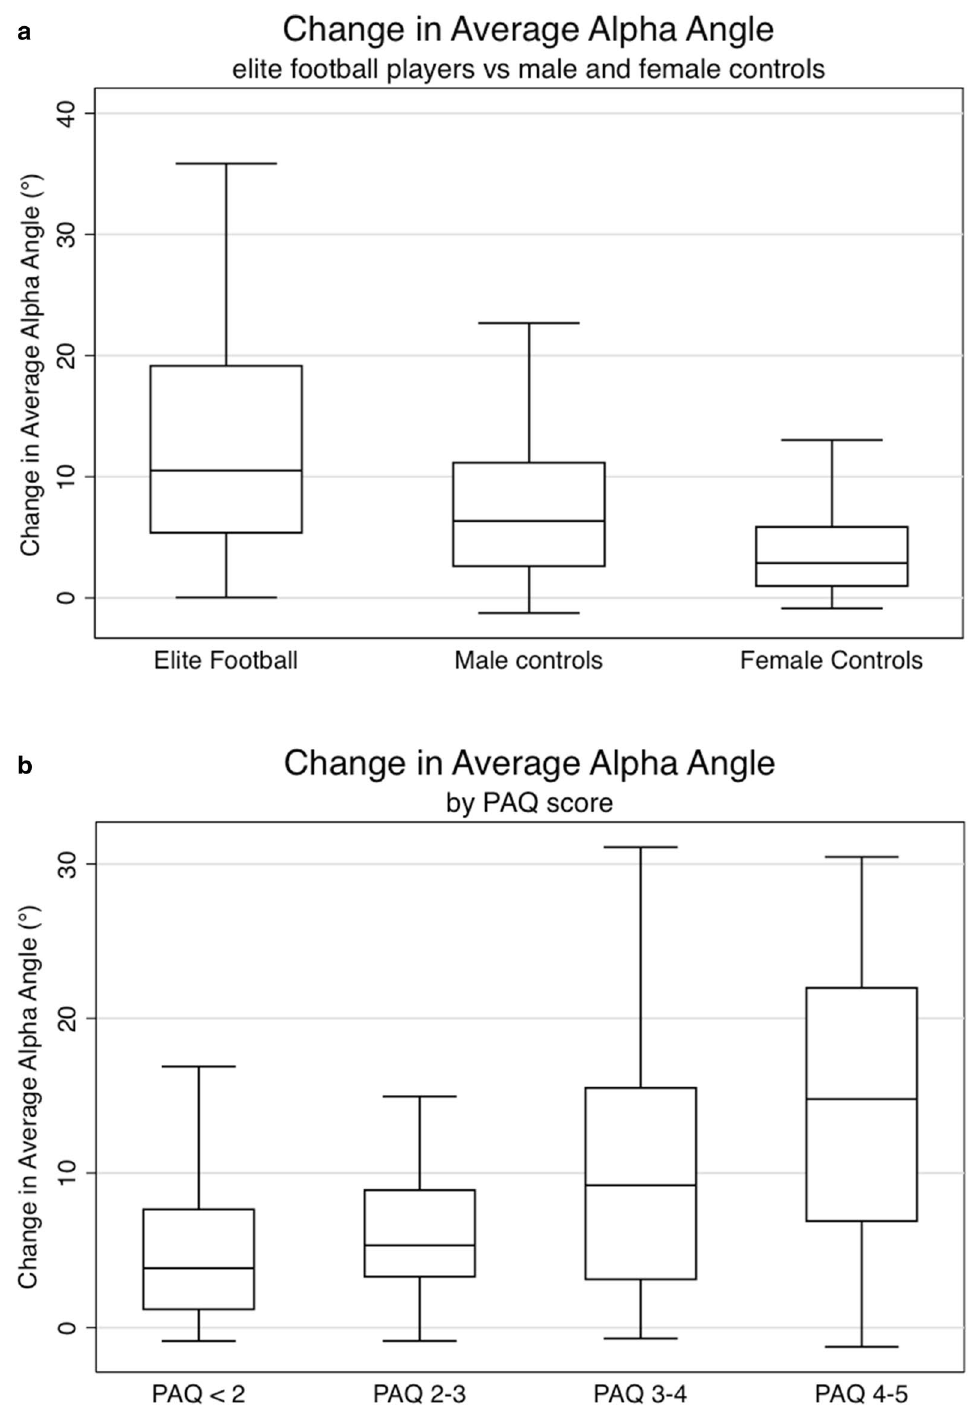
Figure 2. (a) Change in average cartilage alpha angle in individuals from the elite footballer players, male controls, and female controls. Box and whisker plot. (b) Change in average cartilage alpha angle by PAQ score at baseline. Box and whisker